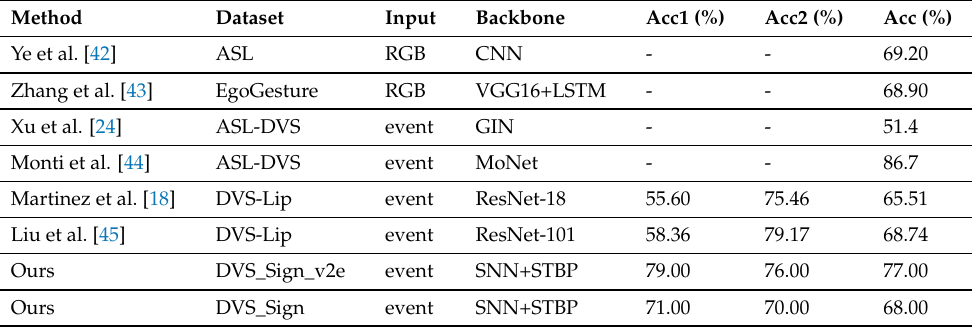
Table 2. Comparison of the v2e dataset with the DAVIS346 acquisition dataset and other event-based and traditional video dataset-based action classification models. DVS_Sign_v2e is a dataset that converts traditional LSA sign language videos into event streams through the v2e method. DVS_Sign is the dataset collected by DAVIS346. Acc1 represents the accuracy of the first part of the test set; Acc2 represents the accuracy of the second part of the test set; Acc represents the accuracy of the entire test